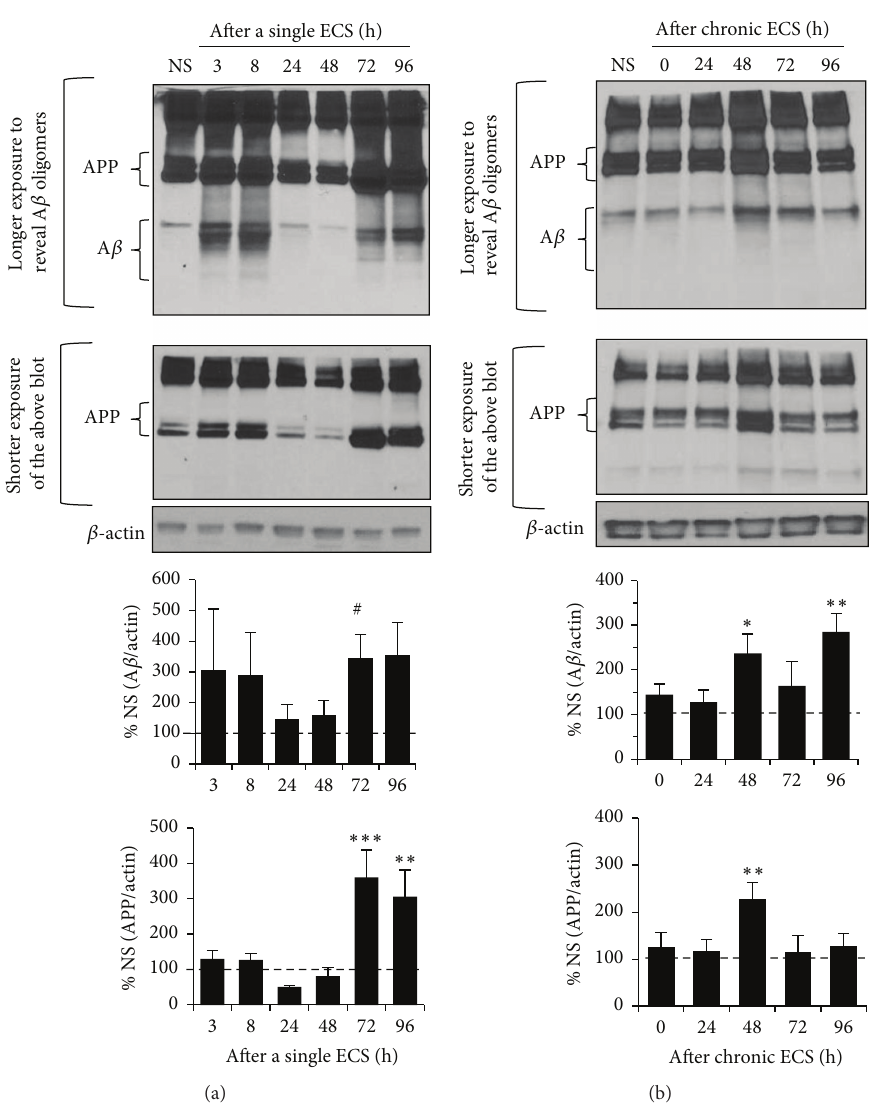
Figure 5: A single ECS and chronic ECS increase APP and oligomeric A 𝛽 expression in the hippocampus. Immunoblot analysis of APP and oligomeric A 𝛽 in the hippocampal crude soluble (S2) fraction following a single ECS ( 𝑛 = 5 rats per time point) (a) and chronic ECS ( 𝑛 = 6 rats per time point) (b). The ratio of the A 𝛽 band intensity over the 𝛽 -actin band intensity (top graphs) and the ratio of the APP band intensity over the 𝛽 -actin band intensity (bottom graphs) were calculated per each time point and normalized to that of “no seizure” (NS) sham group. Data shown represent the mean band intensity ± SEM. (a) A single ECS increases A 𝛽 expression at 72 h ( # 𝑝 < 0.05 , 𝑡 -test) and APP expression at 72–96 h following a single ECS ( ∗∗ 𝑝 < 0.01 , ∗∗∗ 𝑝 < 0.005 ). (b) Chronic ECS increases A 𝛽 expression at 48 h and 96 h, as well as APP expression at 48 h following chronic ECS ( ∗ 𝑝 < 0.05 , ∗∗ 𝑝 < 0.01